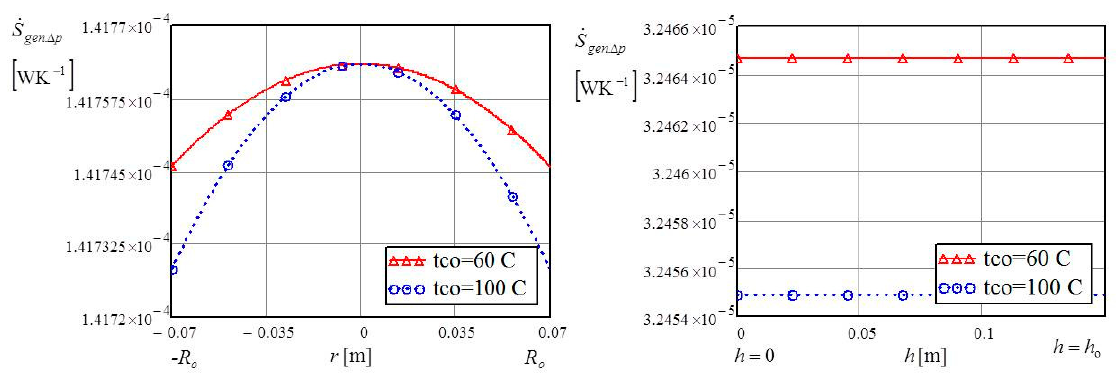
Figure 6. The hydraulic entropy of the bottom and an annular vertical cylindrical